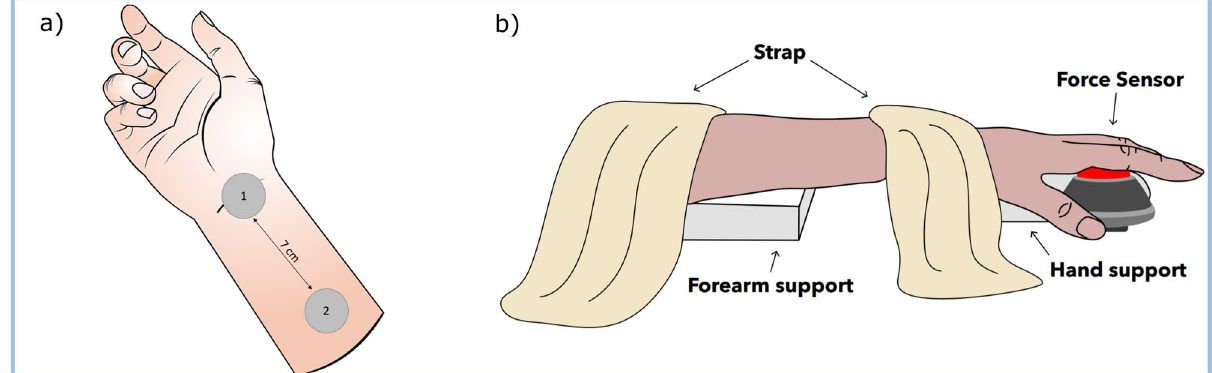
Figure 1. ( a ) Placement of the electrodes. Two electrodes are placed on the lower arm of the subject. Electrode 1 is placed on top of the carpal ligament. Electrode 2 is placed seven cm superior to electrode 1. ( b )